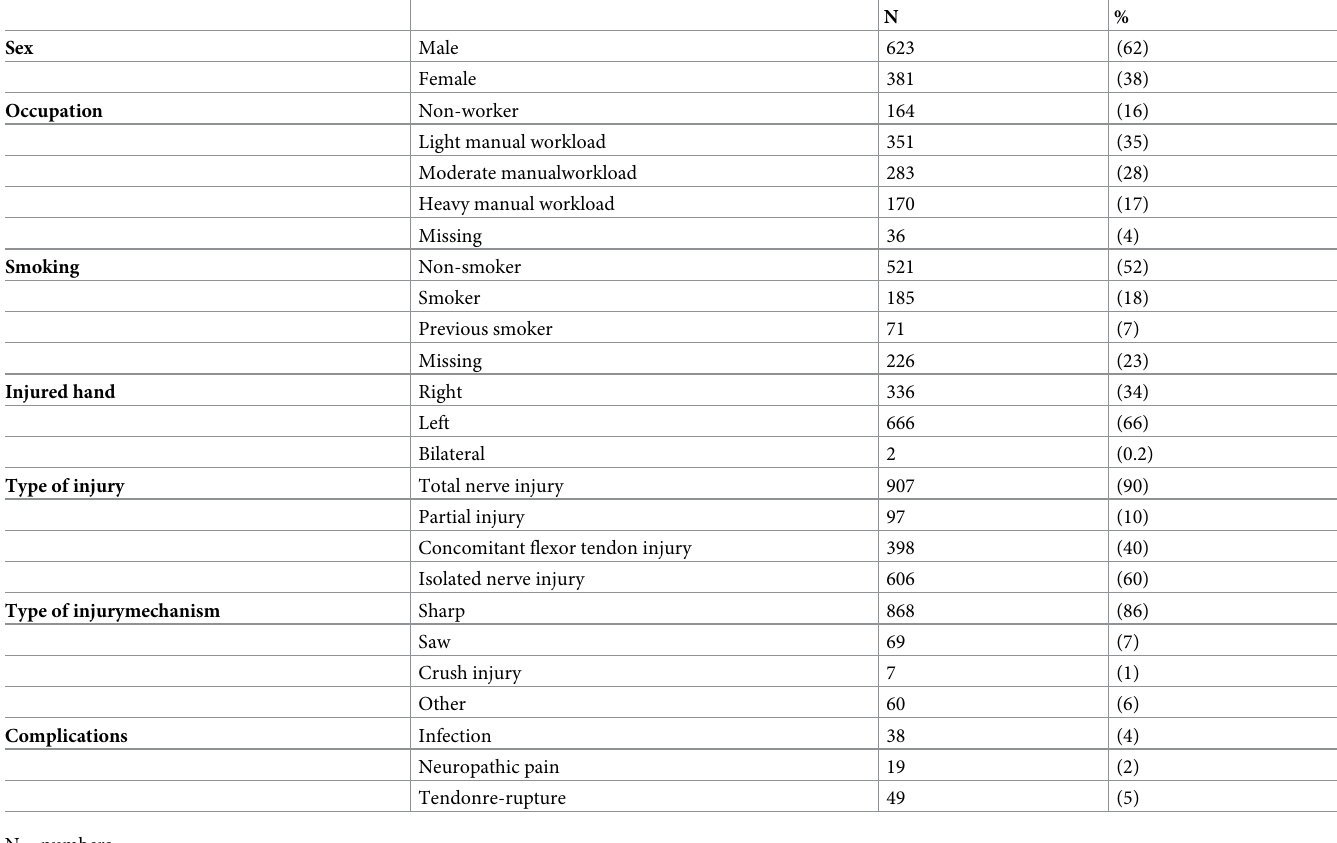
Table 2. Demographics of 1004 patients treated surgically for a digital nerve injury in Stockholm, Sweden, 2012–2018.